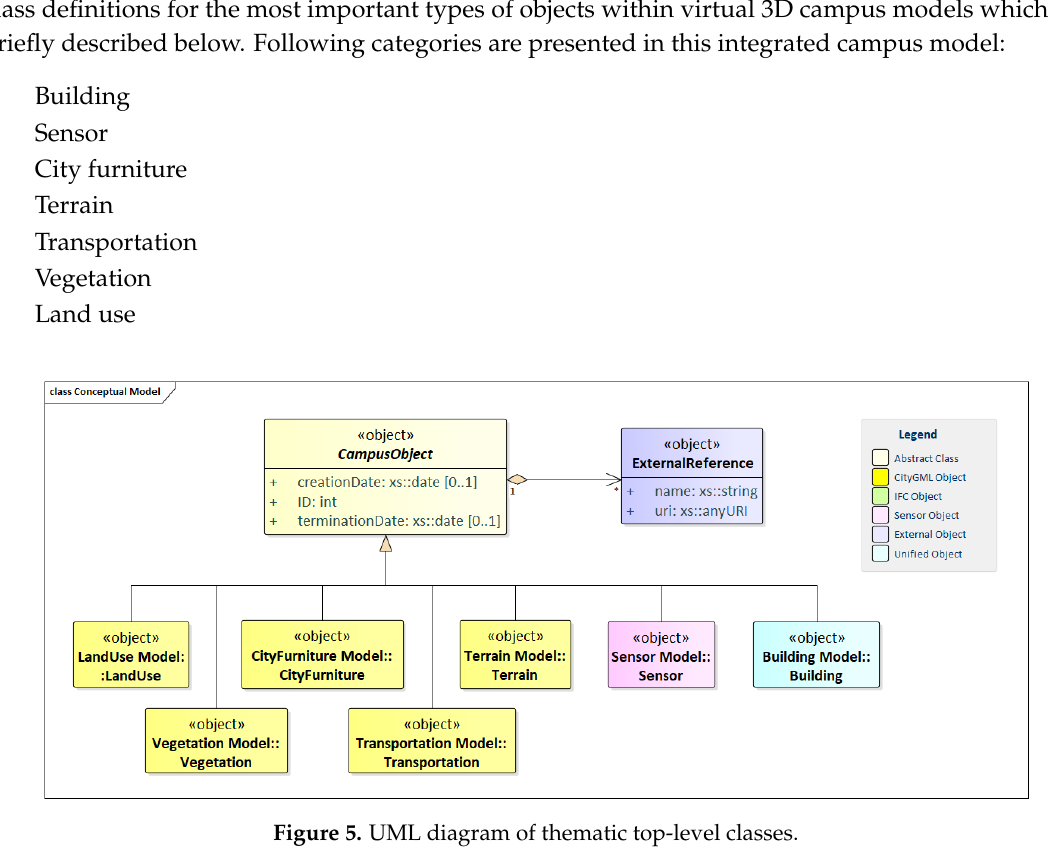
Figure 5. UML diagram of thematic top-level